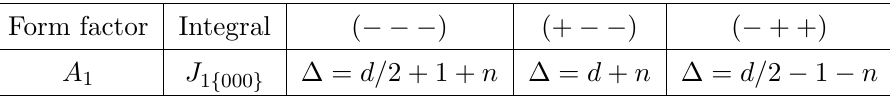
Table 1 . Singularities arising for h J (cid:22) 1 O I 2 O I 3 i , with (cid:1) = (cid:1) 2 = (cid:1) 3 . Secondary